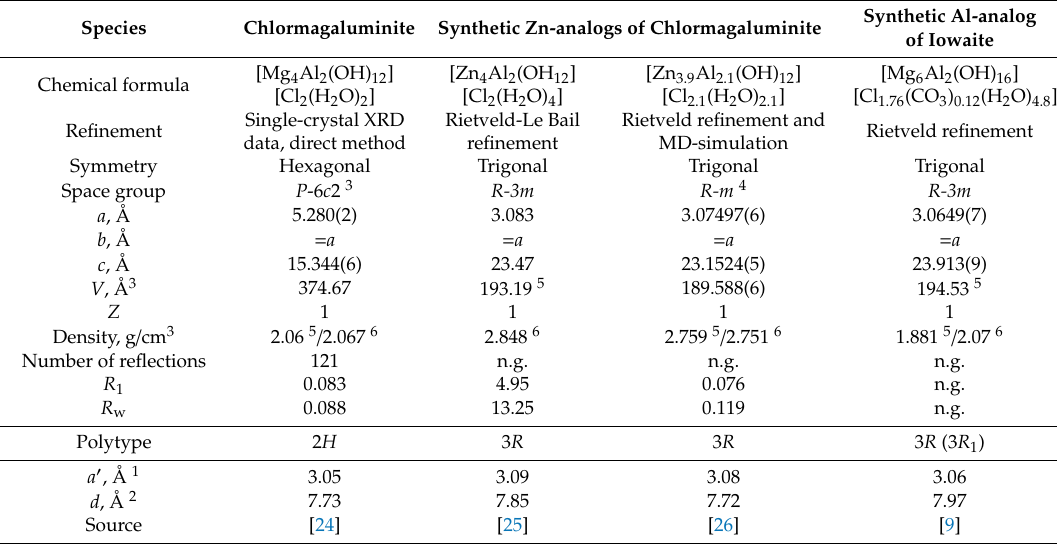
Table 1. Crystallographic data and refinement parameters reported for chlormagaluminite, its synthetic Zn-analog, and for synthetic Al-analog of iowaite. Chlormagaluminite Synthetic Zn-analogs of Chlormagaluminite